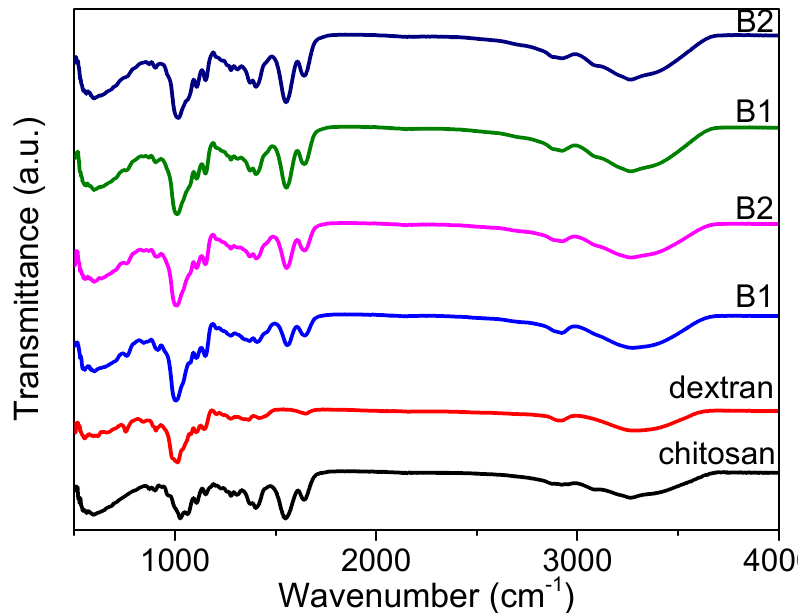
Figure 2. FTIR spectra for chitosan, dextran, and their nanocomposites. The FTIR analysis also portrayed the spectra of chitosan, dextran, and the nanocom- posites (B1, B2, B3, and B4) in the glycosidic linkage (C-O-C), amine, and hydroxyl band regions [24]. The glycosidic linkage band peak for dextran arose at 905 cm − 1 , while the peak for chitosan was at 1027 cm − 1 . The glycosidic band peak was transformed from 903 cm − 1 to 915 cm − 1 when dextran was increasingly incorporated into the chitosan, while the amine band peak was shifted from 1552 cm − 1 to 1558 cm − 1 . The amine band for chitosan was centered at 1550 cm − 1 , while there was no amine functional group for dextran. Moreover, the amine band peak was moved to 1558 cm − 1 in the spectrum of B1, and the peak continued to shift to a lower wavenumber of 1552 cm − 1 for B4. This is evidence of the interaction between the nitrogen atoms of the polymer matrix with the cations [21]. The broad hydroxyl band peak of dextran was located at 3288 cm − 1 , while that of chitosan was centered at 3264 cm − 1 . The position of the hydroxyl peak for B4 was similar to that for chitosan. This could result from a higher content of chitosan in the nanocomposite. The changes (Figure 2) in peak’s position, intensity, and shape illustrated that hydrogen bonding interactions occured in these regions [25–27]. This convincingly demonstrates the promising potential of the biomemristors for future multi-bit data-storage